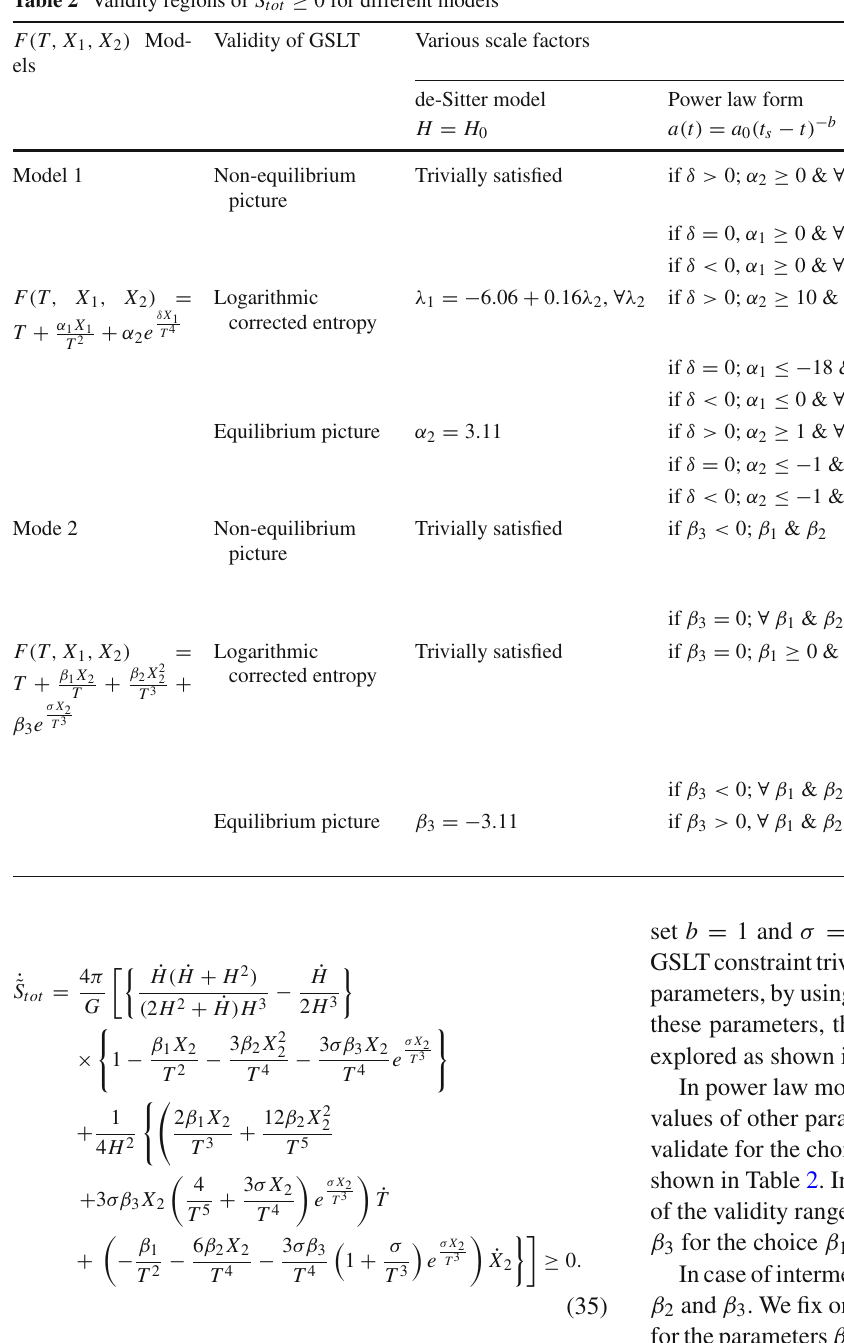
Table 2 Validity regions of F ( T , X 1 , X 2 ) Mod- els